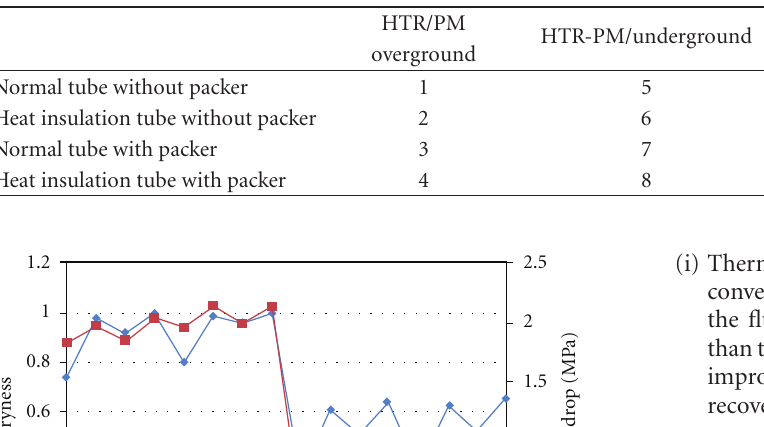
Table 11: Di ff erent scenarios and their serial numbers.